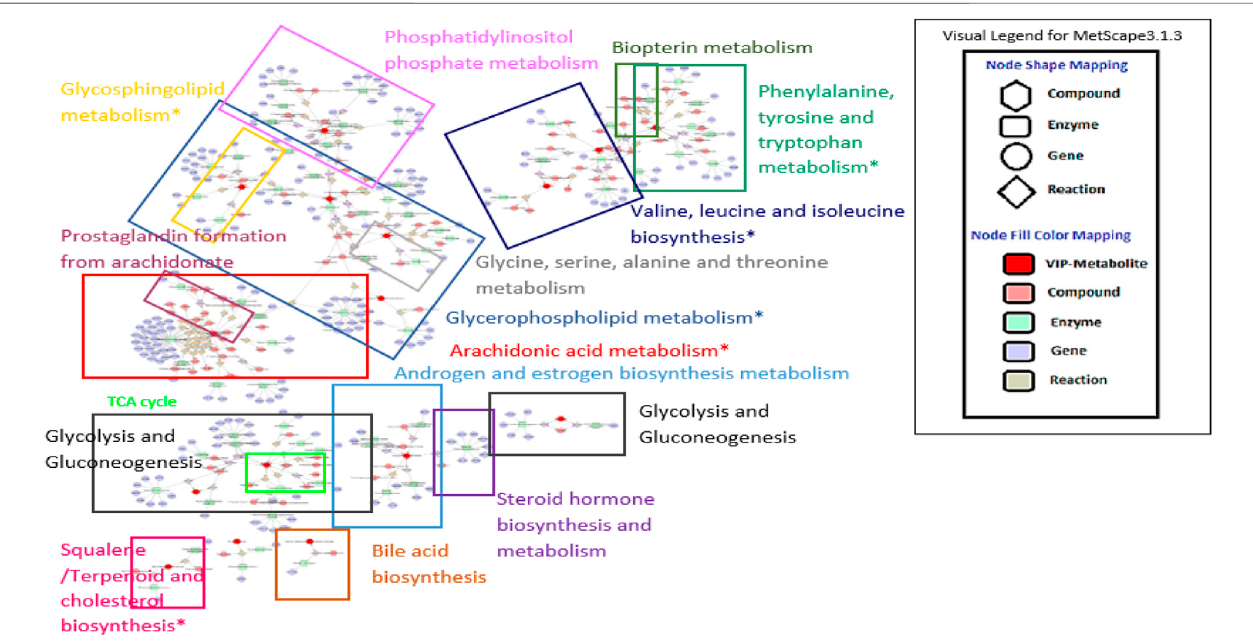
FIGURE 5 | Suggested metabolic system by MetScape. The map summarizes the shortest route to explain interactions among metabolites with VIP value > 1.3. Sign * indicates the most affected pathway based on the ingenuity pathway analysis computed from MetPa analysis. The clear image can be accessed at http://www. ndexbio.org/#/network/d77dd163-9ad1-11e9-8bb4-0ac135e8bacf?accesskey (cid:2) f1aa0859c5f3b7d9c5507942b02596bd3a1eee60414d960f22920a3a68c10701.